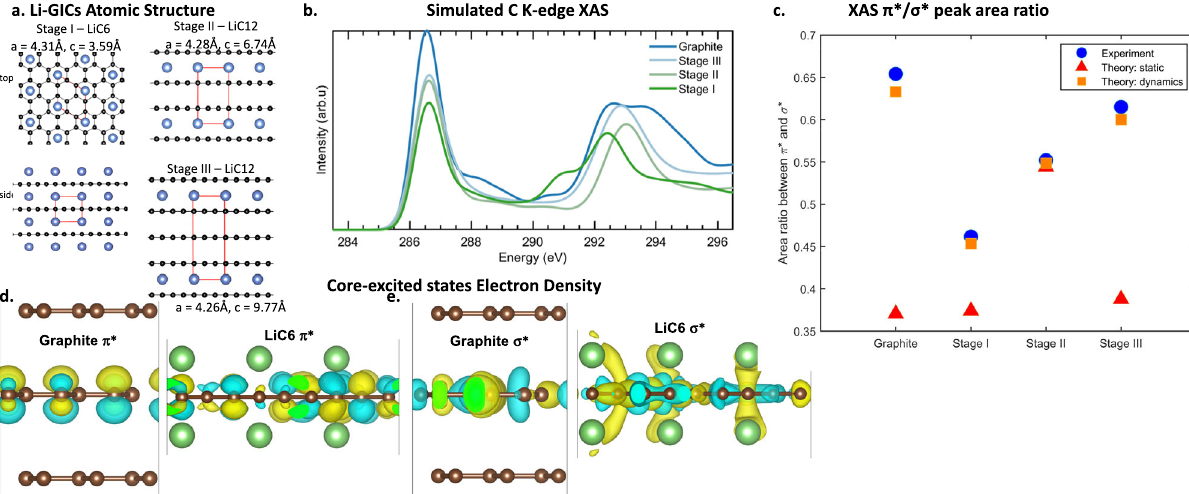
Fig.1|ElectronicstructureofgraphiteandstagedLi-GICs.a Schematicshowing Li staging of graphite. b Simulated C K-edge of pristine graphite and all three Li- GICs, using samples from AIMD trajectories. c Comparison of the π */ σ * peak area ratio for the various Li-GICs, from experiment 14 (blue circles), simulations of the static0Koptimizedstructure(redtriangles)andsimulationssampledfroma298K AIMD trajectory (orange squares). d Visualization of the π * core-excited state